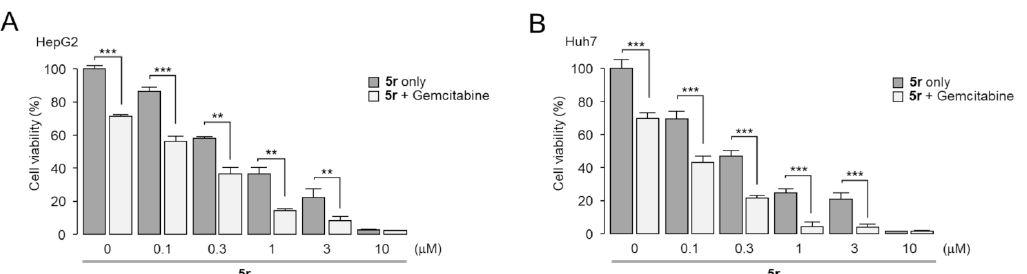
Figure 6. Combination effect of 5r and gemcitabine on cell viability in HepG2 and Huh7 cells. ( A , B ) HepG2 and Huh7 cells were cultured with the indicated concentrations of 5r and gemcitabine (0.3 µ M) for 72 h, and medium was replaced every 24 h with freshly added 5r and gemcitabine. Cell viability was determined by MTS analysis (mean ± S.D., n = 5). ** p < 0.01, *** p <